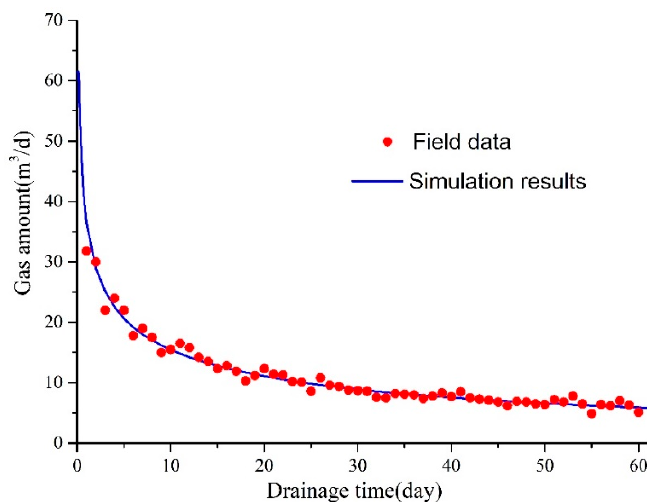
Figure 5. Comparison between field data and simulations results.